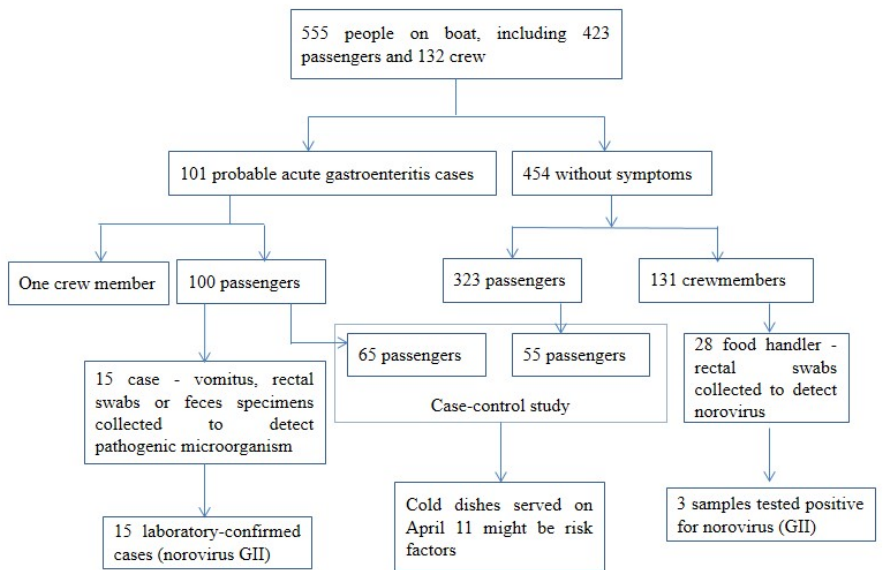
Figure 1. A brief flow-diagram of the norovirus outbreak occurred on cruise ship, Chongqing, China, 2017.